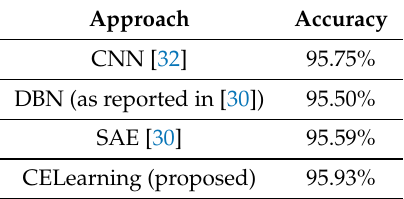
Table 4. Comparison of different methods based on automatic feature